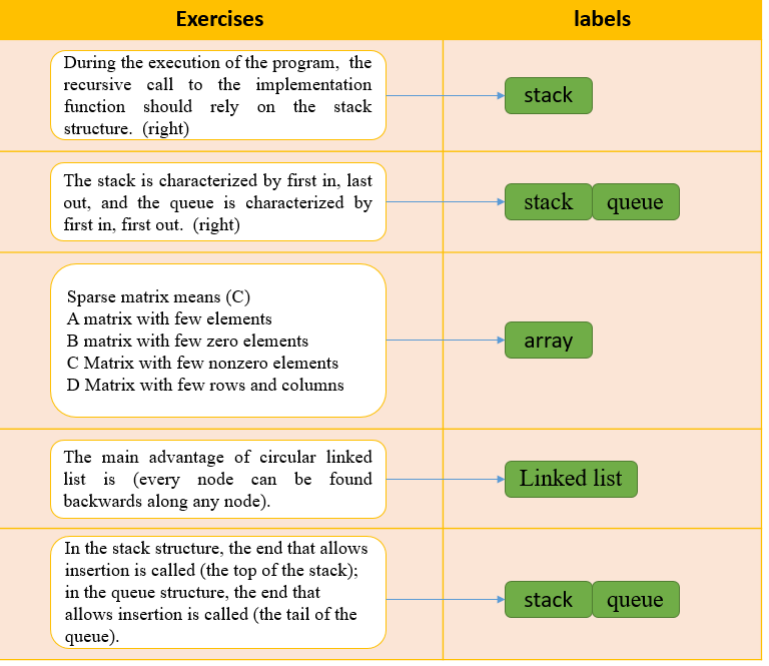
Figure 1. Examples of exercises linking to knowledge concepts from